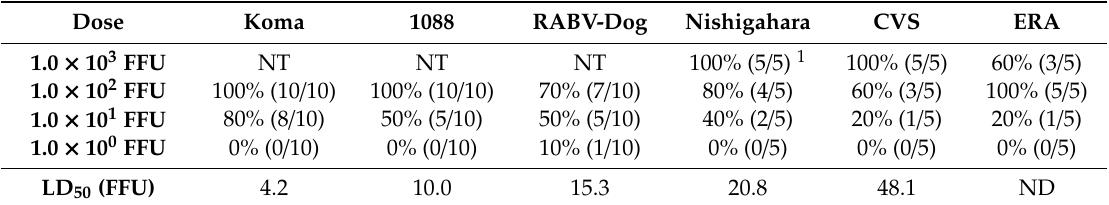
Table 2. Pathogenicity of each of the virus strains in mice after i.c. inoculation. Dose Koma